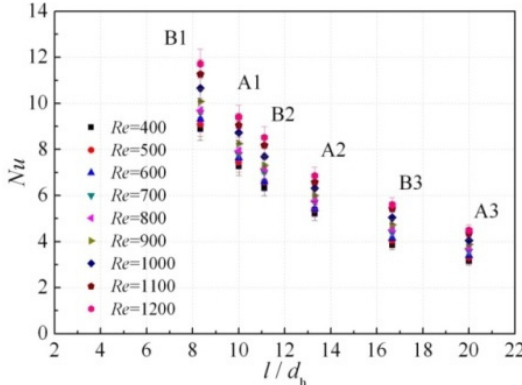
Figure 5. Nusselt number variation with l / d h , Va = 150.